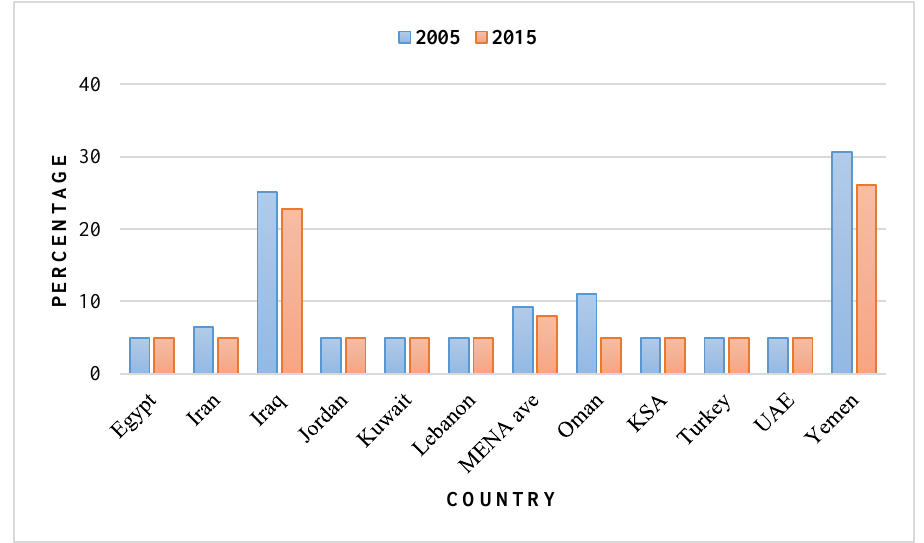
Figure 11. Percentage of undernourished population in each country of the Middle East. Note: data for Syria was not available. The data is acquired from: https://idea.usaid.gov.